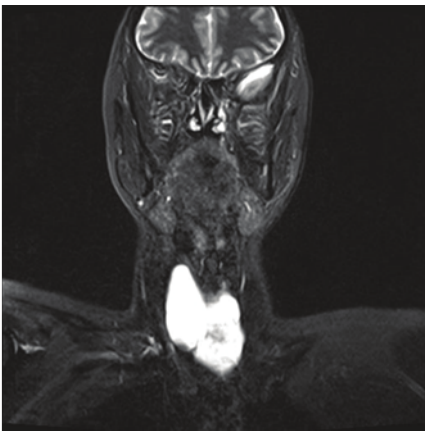
Figure 1: T2-weighted coronal MRI demonstrating a pyramidal shaped cystic lesion in continuity with the lower portions of both thyroid lobes.